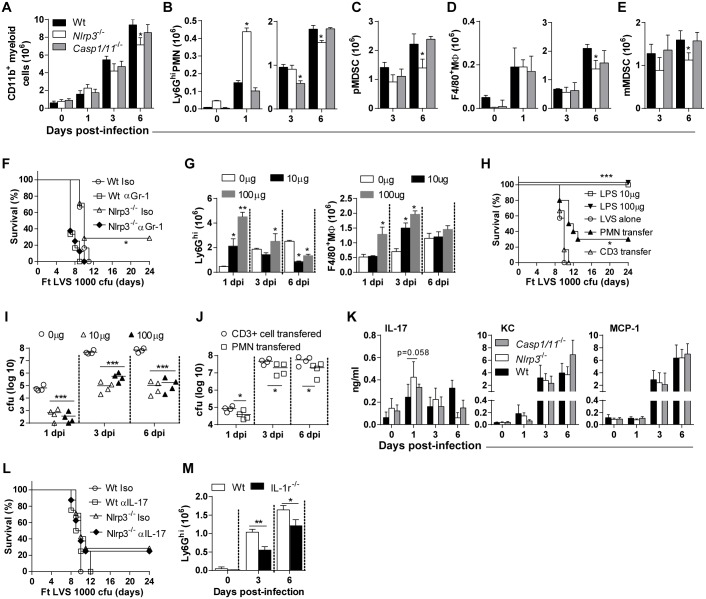
An early neutrophil response in Nlrp3-/- mice is protective during pulmonary tularemia.(A-E) Total numbers of CD11b+ myeloid cells, Ly6G+ neutrophils, polymorphonucleated-MDSC (pMDSC), F4/80+macrophages or mono-nucleated-MDSC (mMDSC) in LVS-infected lungs (mean ± SD of two independent experiments, n = 6 mice, Student’s t-test, *p<0.05 indicates difference from wildtype mice at specific dpi). (F) Survival of mice following Ft LVS (1000 cfu) infection and treatment with anti-Gr-1 antibody (200μg/mouse, i.p route) at -1 and 1 dpi (% survival of two experiments, n = 6 mice, Log-rank test, *p<0.05). (G) Total numbers of Ly6Ghigh neutrophils in lungs of mice following i.n. instillation of LPS and infected 48 h later with Ft LVS (1000 cfu) (mean ± SD of three mice, Student’s t-test, *p<0.05 and **p<0.01 indicate the difference from those mice receiving no LPS but infected with LVS). (H) Survival of mice following Ft LVS (1000 cfu) infection. Naïve mice were first adoptively transferred with PMN (1 x106 cells/mouse; isolated from bone marrow cells) or CD3+ T cells (1 x106 cells/mouse; isolated from spleen) by intratracheal intubation and infected with Ft LVS on the following day. Other groups of naïve mice were treated with LPS (100 or 10 μg/mouse, i.n instillation) to elicit PMN/myeloid cell response, infected with Ft LVS after 48 h, and monitored for survival and mortality (% survival of two independent experiment, n = 10 mice, Log-rank test, *p<0.05 or ***p<0.001 indicates difference from naïve mice infected with LVS alone). (I) Lung bacterial burden in mice receiving i.n. instillation of LPS and infected 48 h later with Ft LVS (1000 cfu) (mean ± SD of four mice, Student’s t-test, *p<0.05 and **p<0.01 indicate the difference from those mice receiving no LPS but infected with LVS). (J) Lung bacterial burden in mice receiving PMN or CD3+ T cells post-infection with Ft LVS (1000 cfu) (mean ± SD of four mice, Student’s t-test, *p<0.05 and **p<0.01). (K) Levels of IL-17, KC and MCP-1 in lung homogenates (mean ± SD of two independent experiments, n = 6 mice, Student’s t-test). (L) Survival of mice following Ft LVS (1000 cfu) infection and treatment with anti-IL-17 antibody (200μg/mouse, i.p route) at 1 and 3 dpi (% survival of two independent experiments, n = 8 mice, Log-rank test). (M) Total numbers of Ly6Ghigh neutrophils in lungs of wildtype and IL-1r-/- mice infected with lethal (1000 cfu) Ft LVS (mean ± SD of two independent experiments, n = 6 mice, Student’s t-test, *p<0.05 and **p<0.01).